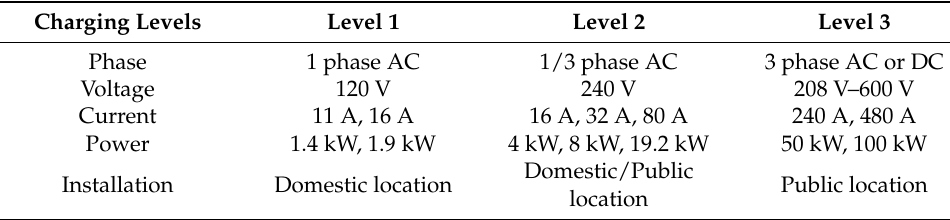
Table 1. Charging level of EVs according to Refs.